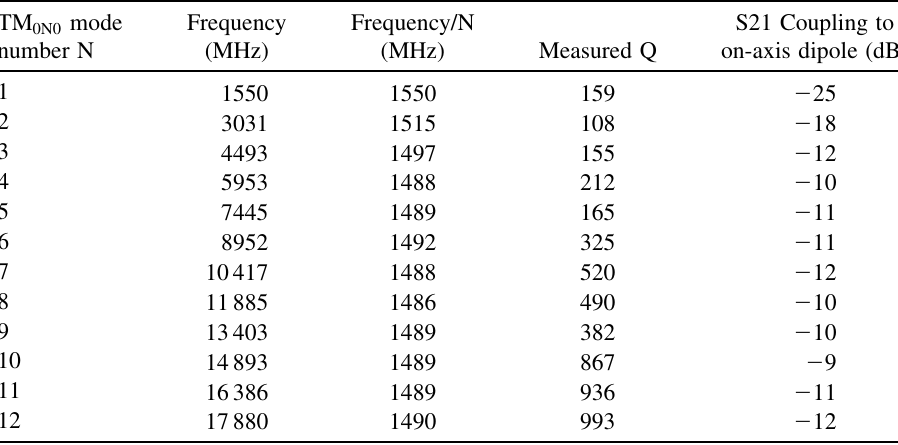
TABLE I. Bench test measurements for the bunch-length monitor with bolted-together cavity halves and intervening wire seal. Similar results were obtained for the welded bunch-length monitor used for beam-based measurements.